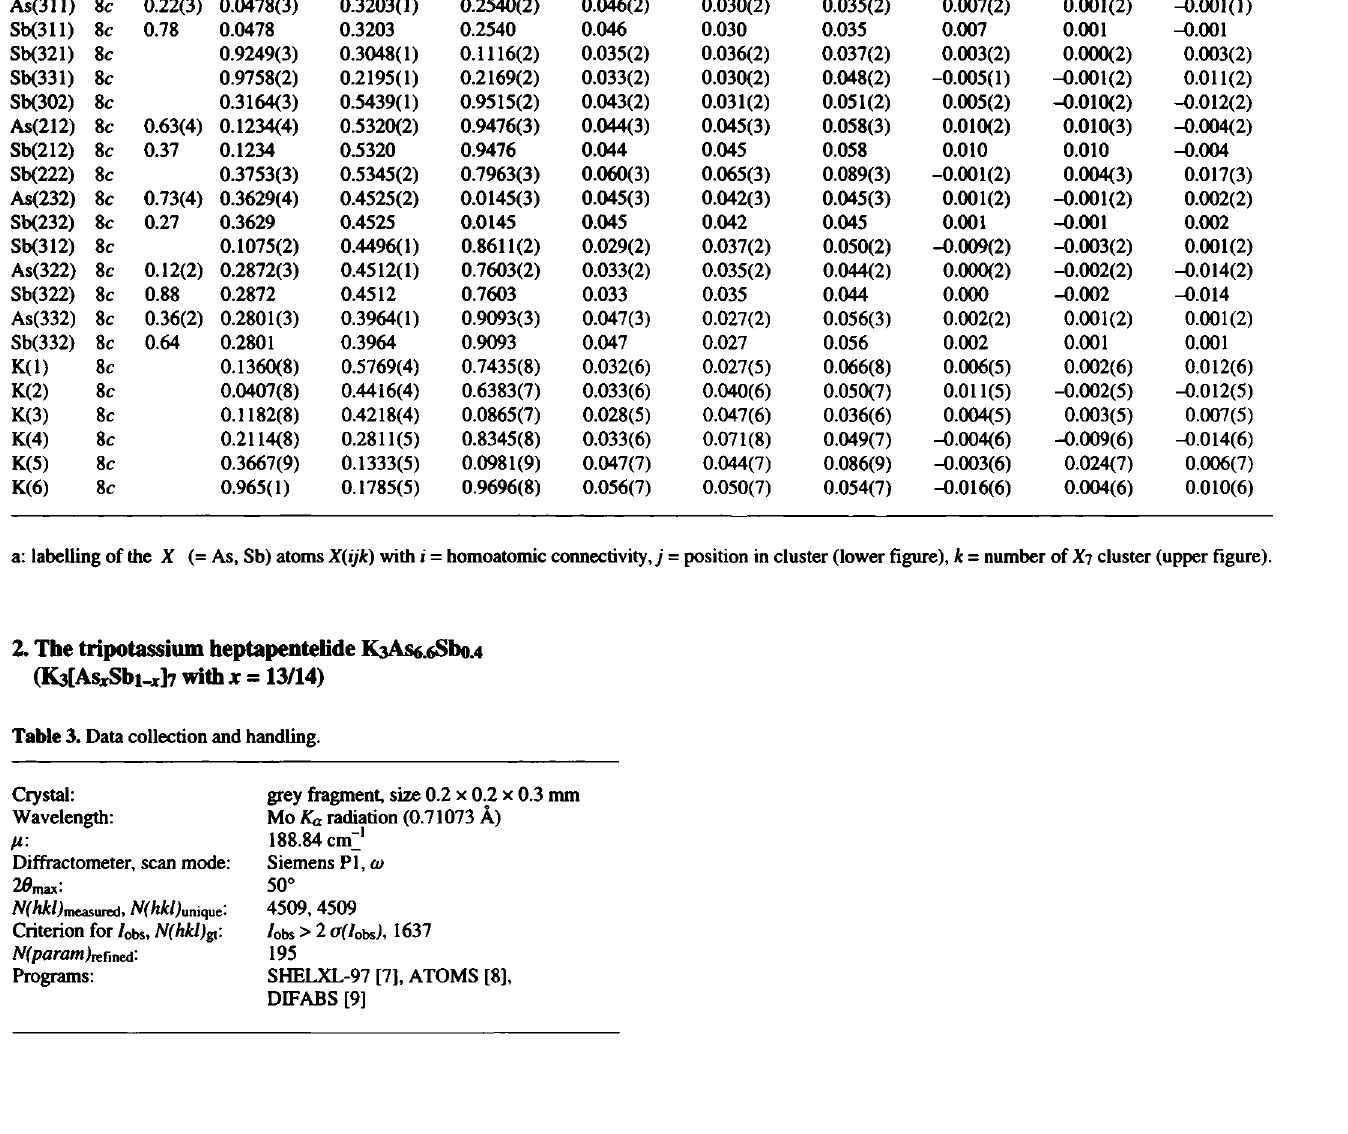
Table 2. Atomic coordinates and displacement parameters (in Â 2 ). Atom Site Occ.